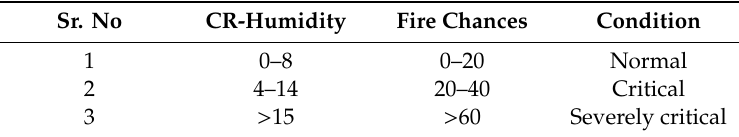
Table 7. Experimental analysis of CR-Humidity (%).